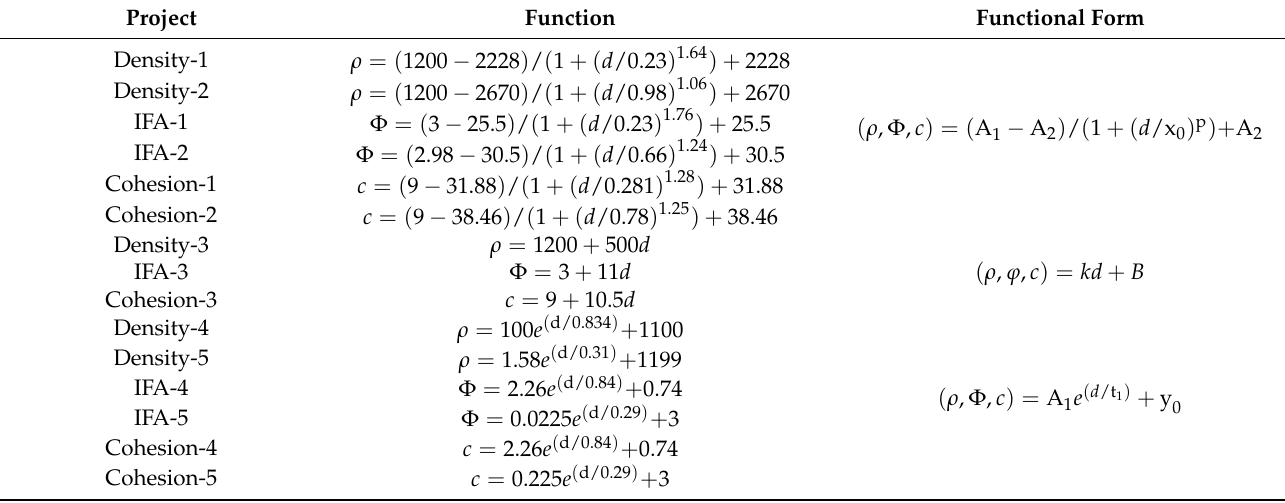
Table 12. Soil parameters as a function of